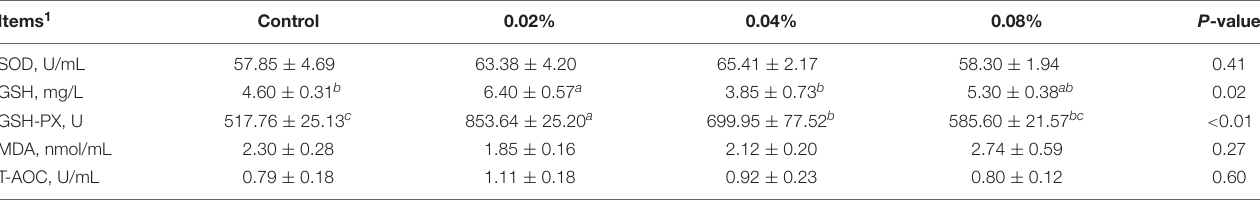
TABLE 4 | Effects of different levels of dietary CGA supplementation on serum antioxidant parameters of the finishing pigs.